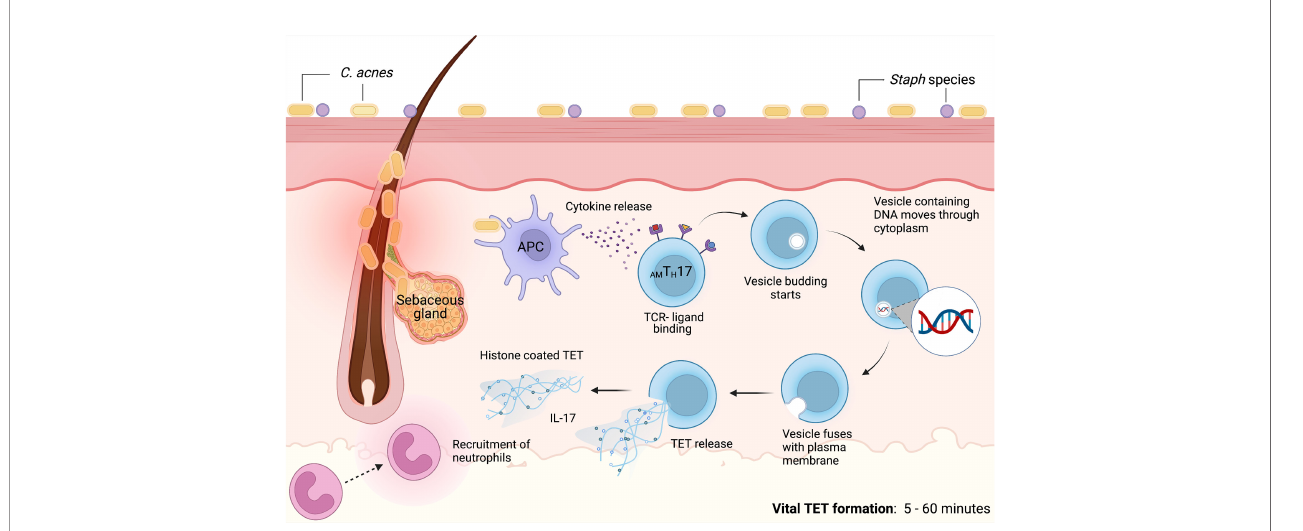
FIGURE 3 | Proposed mechanism of vital TET formation in acne. In the pilosebaceous follicles, C. acnes strains trigger antigen presenting cells to secrete cytokines that induce naïve T cells to differentiate into distinct T cell subsets. Upon induction, AM T H 17 cells can further be activated by bacterial ligands, PMA and other stimuli. TCR-ligand binding induce the formation of vesicles containing DNA. Blebbing of T cell nuclear envelope, vesicular exportation and exocytosis of vesicles containing DNA generate extracellular traps while preserving the integrity of the cell. As a result, AM T H 17 cells retain conventional functions of viable T cells such as cytokine secretion. In vitro , we have observed that AM T H 17 cells release TETs as early as 30 minutes after stimulation with C. acnes . Both the released TETs and IL-17 can recruit neutrophils to in fl amed acne lesions. TETs trap C. acnes and are also loaded with antimicrobial molecules, including granulysin and histone H2B, H3 and H4 that kill bacteria. Created with